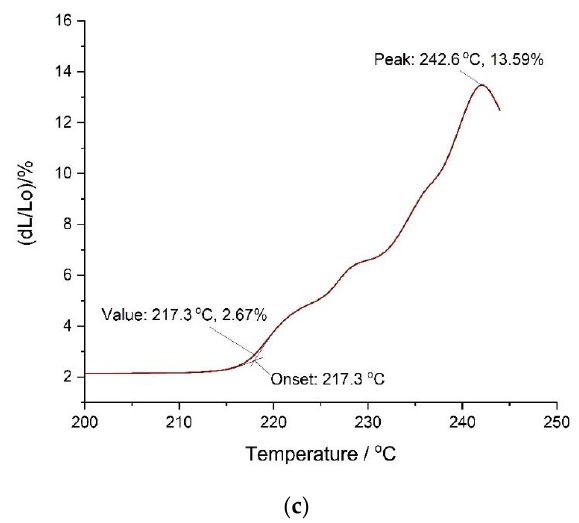
Figure 8. Dilatometric curve of sample 2 of reference (I). ( a ) whole measurement, ( b ) close-up on the effect in 140–150 °C, ( c ) close-up on the effect above 210 °C .